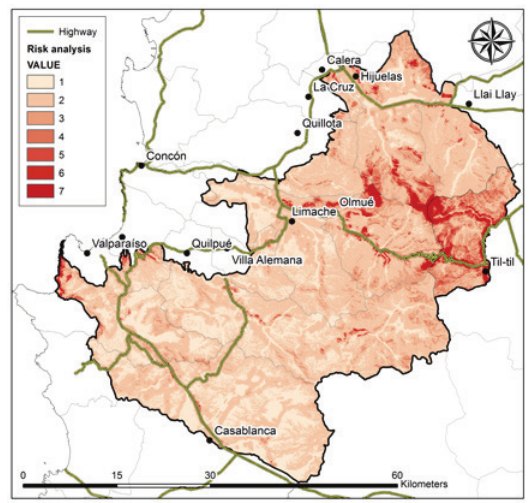
Figure 5. Wildfi re